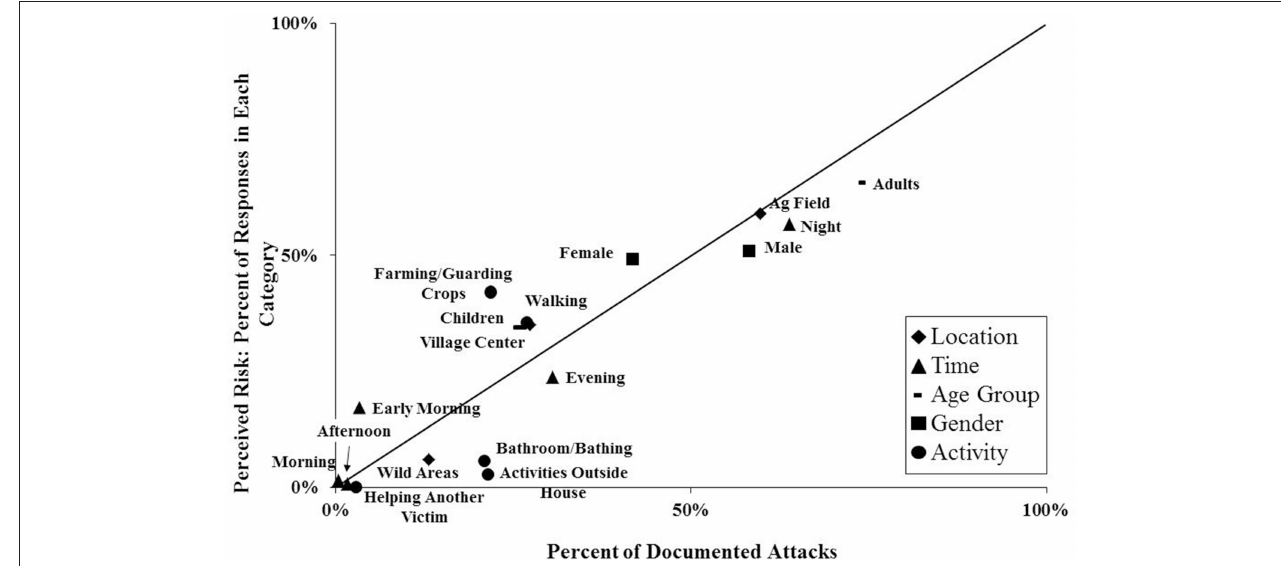
FIGURE 2 | Comparison of perceived risk vs. information from documented lion attacks. Risk-perception responses for locations, times, activities, age groups, and gender are plotted against information from documented attacks. The closest points to the diagonal line show the closest alignment between perceived and actual attack risks. Points below the line show when people underestimated the risks and points above the line show when people overestimated the